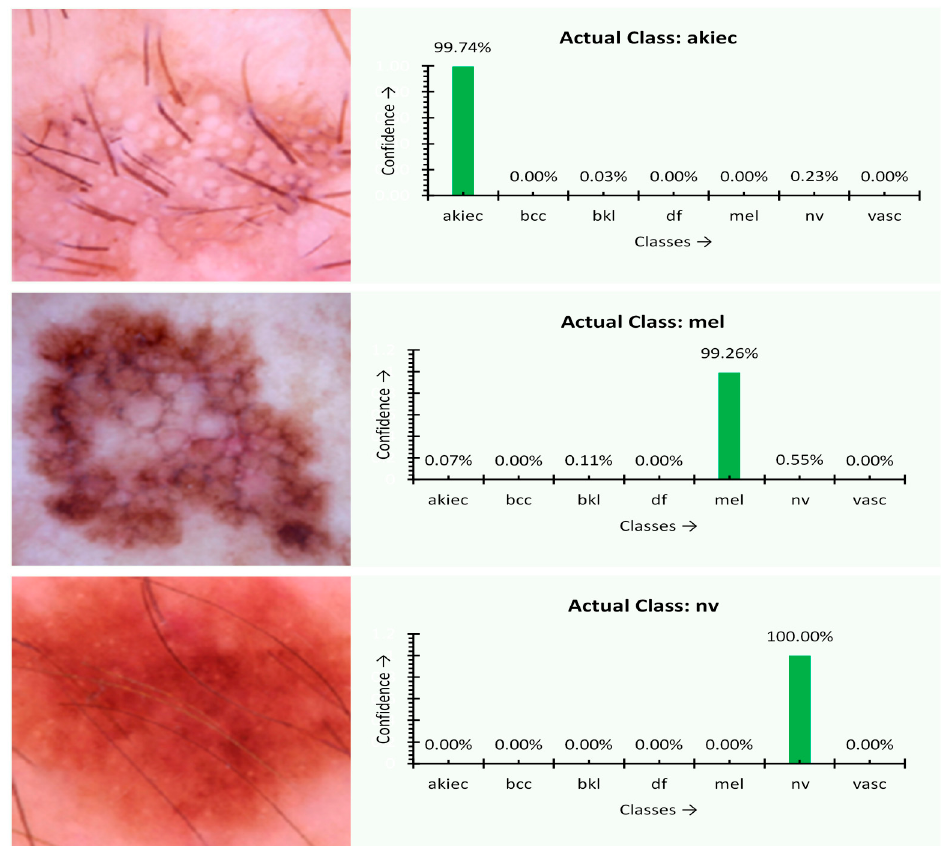
Figure 7. Classification confidence and resultant output images of the final model.